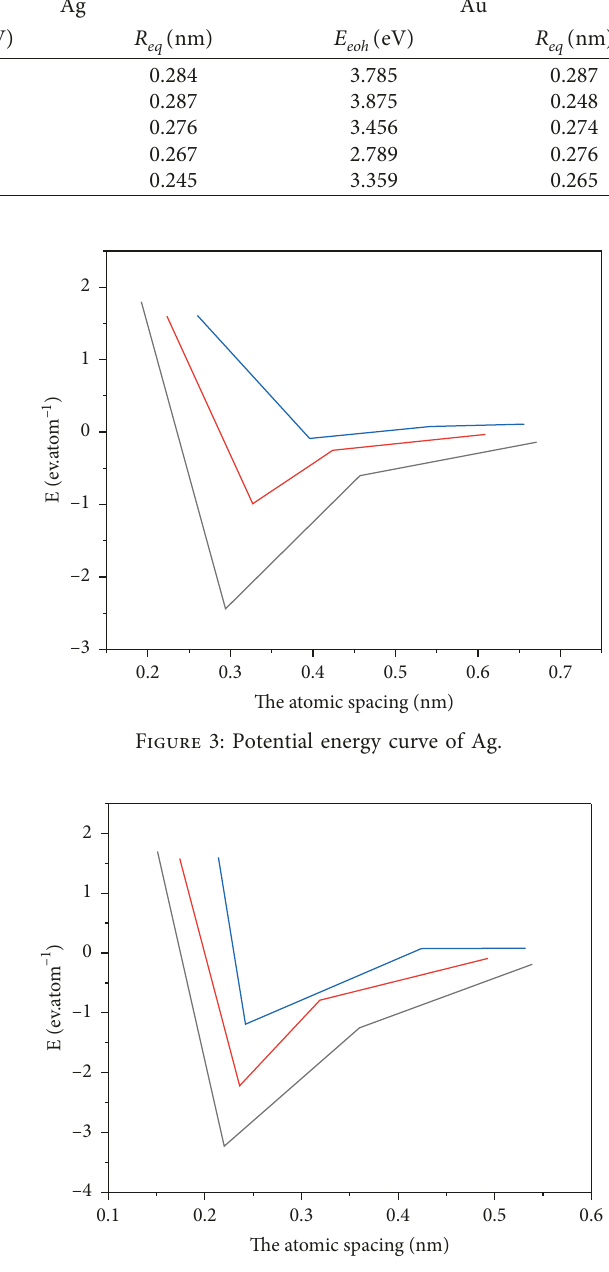
Figure 4: Potential energy curve of